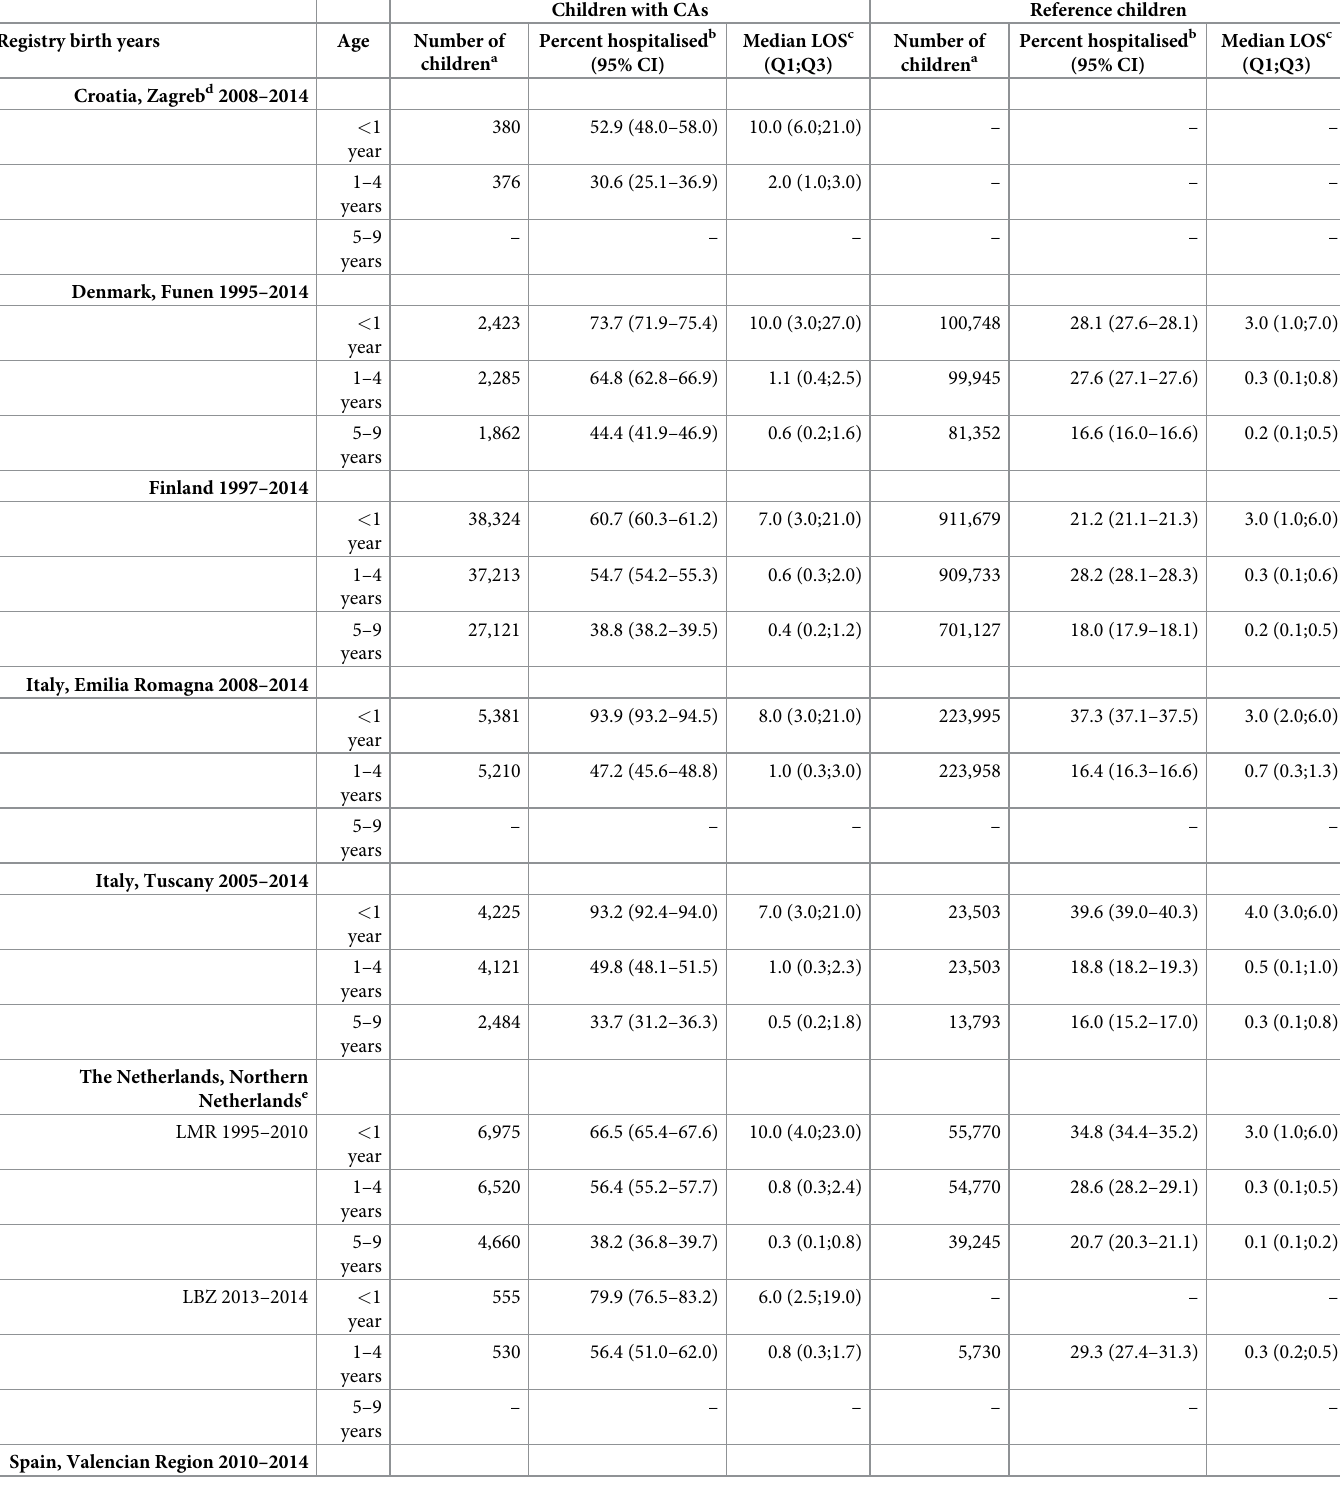
Table 1. Number of children, percentage hospitalised and median length of stay for children with congenital anomalies and reference children by registry and age